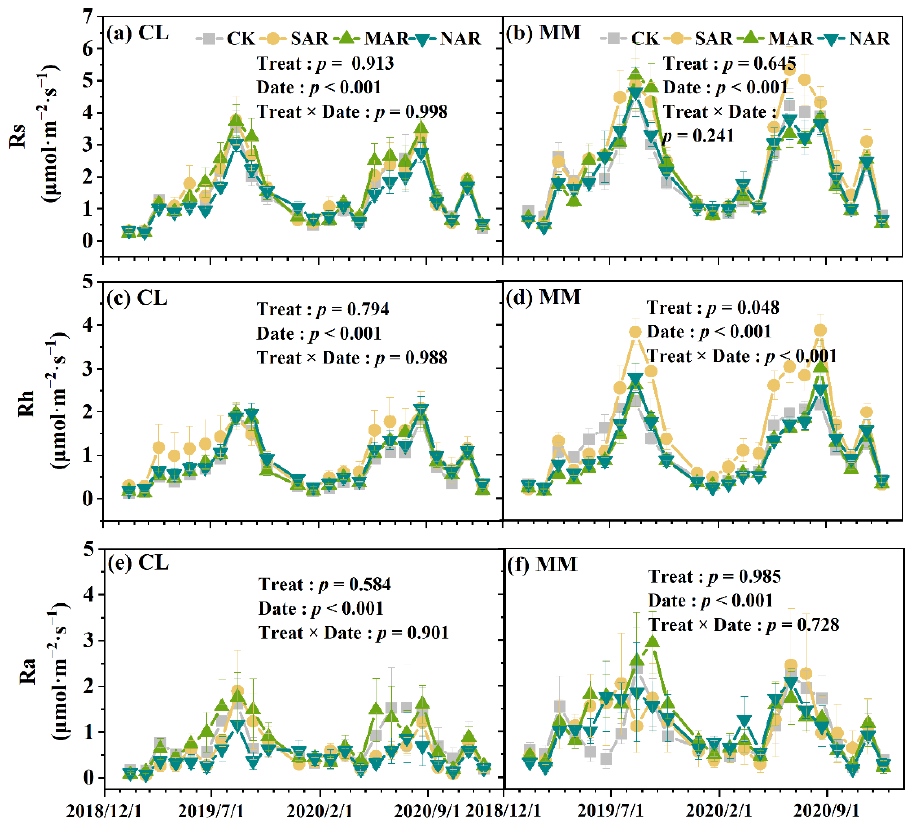
Figure 3. Seasonal variations in soil respiration (Rs) ( a , b ), soil heterotrophic respiration (Rh) ( c , d ), and soil autotrophic respiration (Ra) ( e , f ) under different types of acid rain in Cunninghamia lanceolata (Lamb.) Hook. (CL) and Michelia macclurei Dandy (MM) plantations from January 2019 to December 2020. Vertical bars represent standard errors ( n = 4).